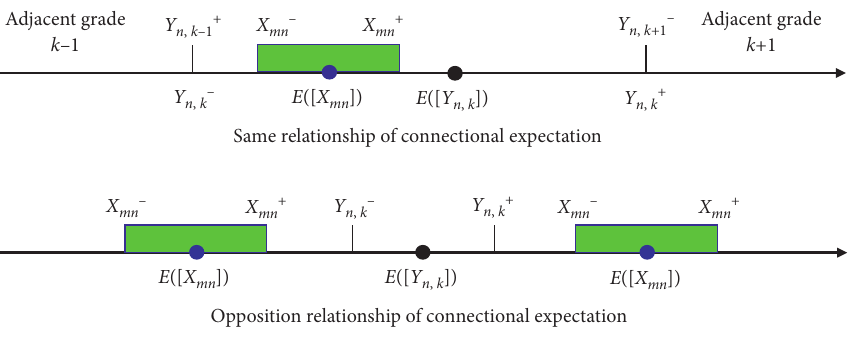
Figure 2: Diagram for same and opposition relationships of connectional